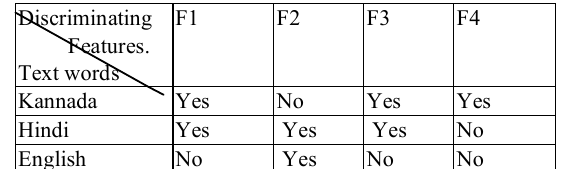
Table-1. Presence and absence of discriminating features of Kannada, Hindi and English text